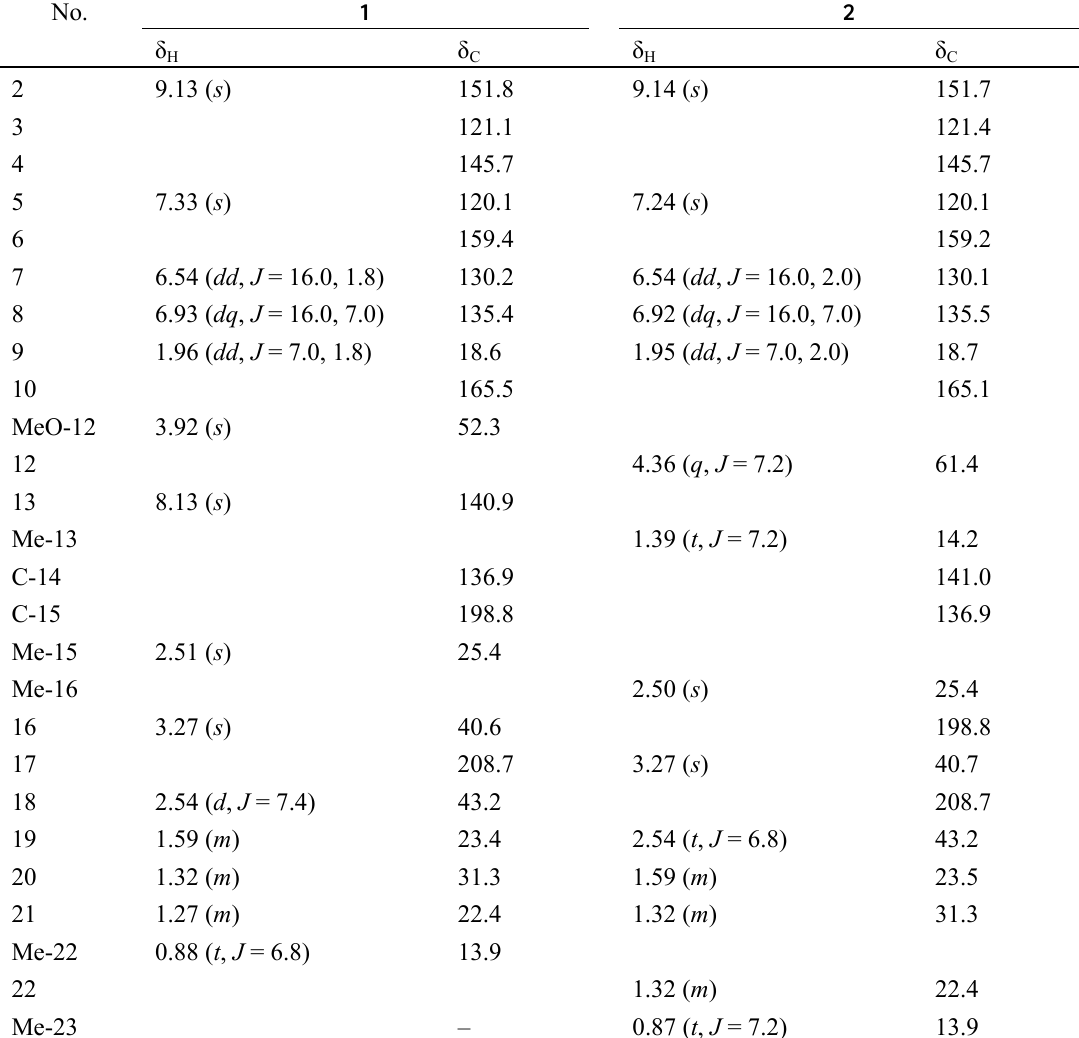
. δ in ppm, J in 3